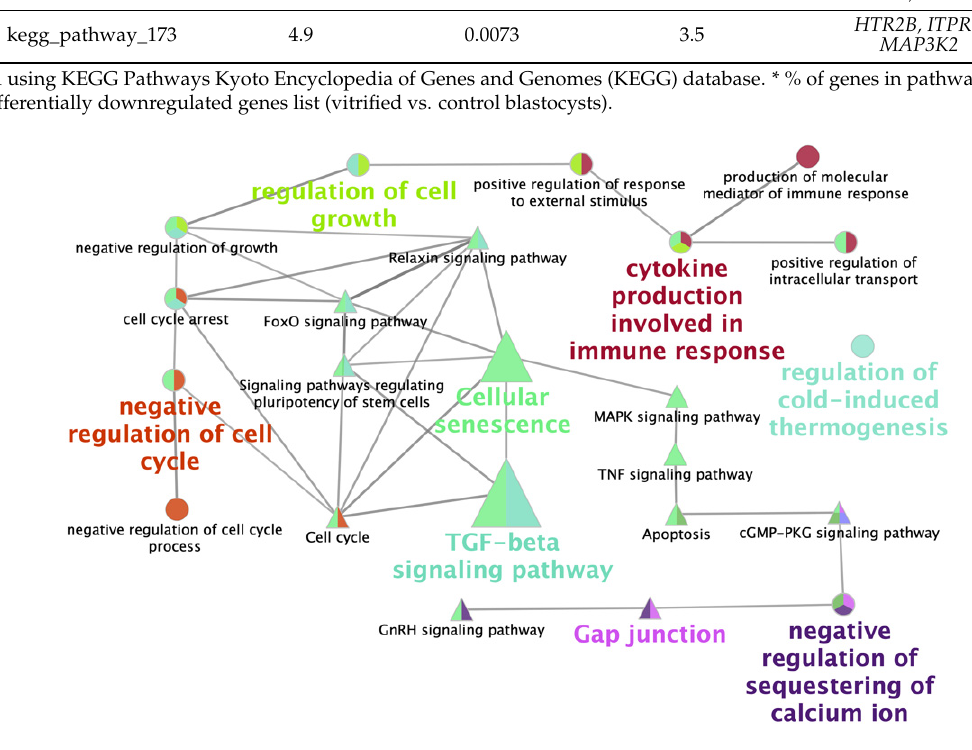
Figure 5. Validation of microarray results by RT-qPCR. The Y-axis represents the fold change between the vitrified and control blastocysts. * Asterisks indicate significant differences between the vitrified and control groups, as determined by RT-qPCR analysis.